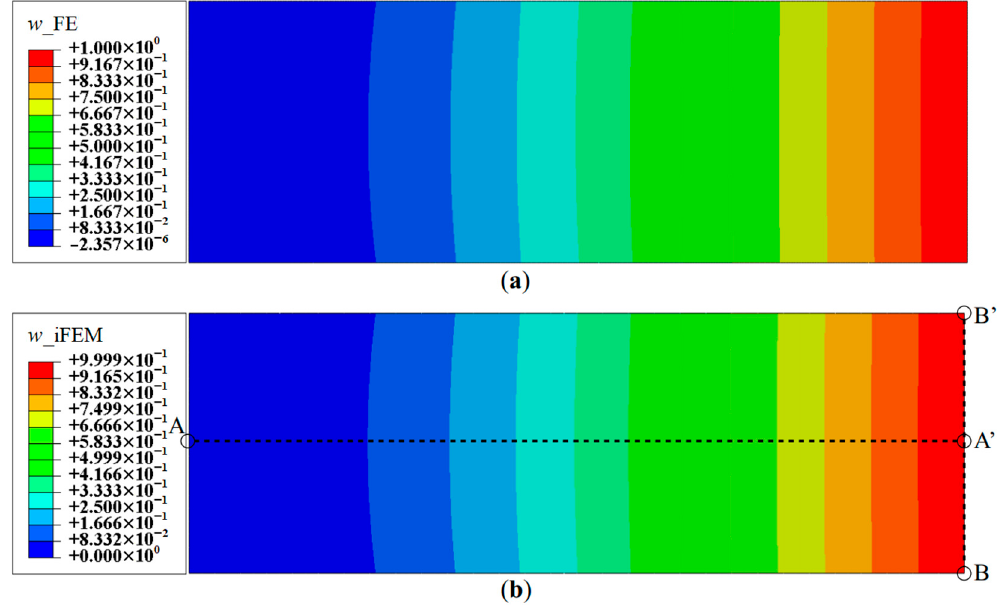
Figure 5. Contour plots of deflection for Mode 1: ( a ) FE results; and ( b ) iFEM results using full-field strain data (Configuration D).